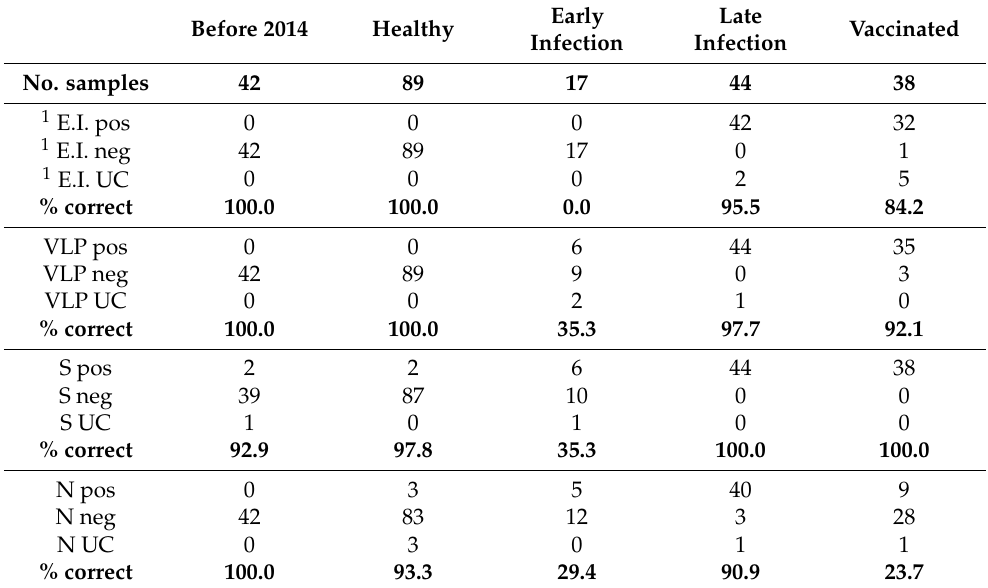
Table 1. Comparison of the performance of the VLP-ELISA and a certified IVD. Early Before 2014 Healthy